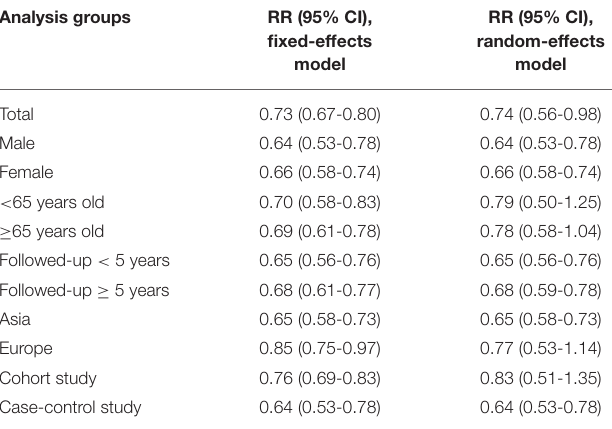
TABLE 4 | Comparison of the results of random-effects vs. fixed-effects